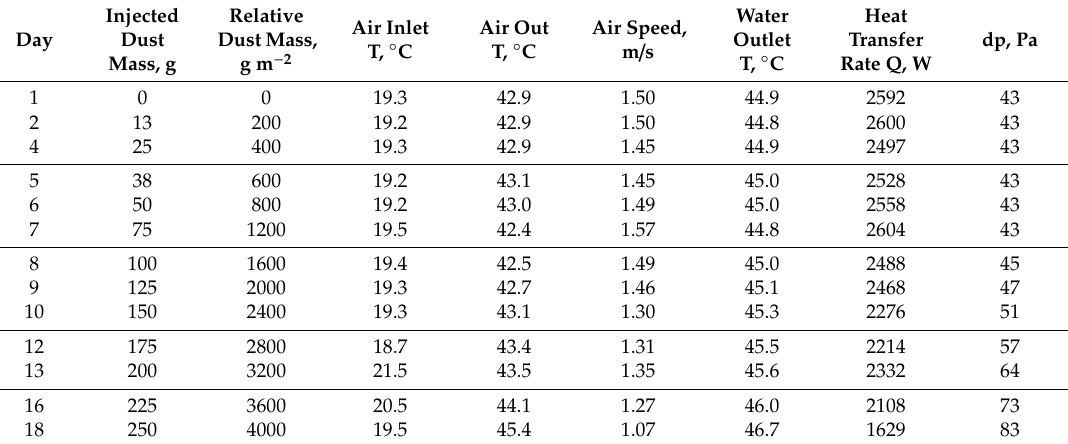
Table 1. Review of experimental data.